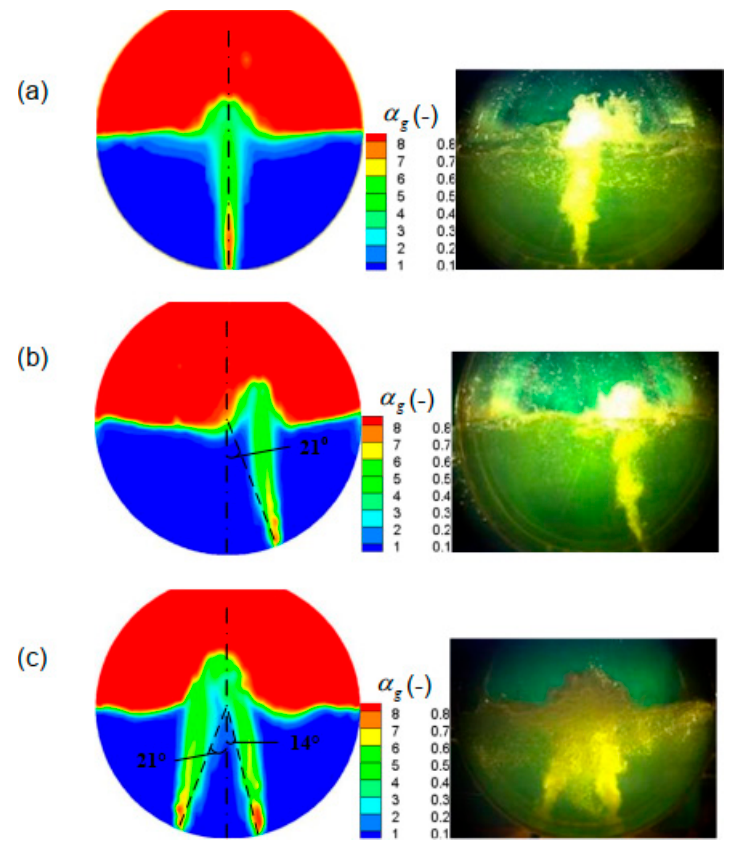
Figure 2. Comparison of the predicted local gas volume fraction with experimental photos in the bath with different nozzle arrangement. The angles of the nozzle arrangement are ( a ) β = 0 ° , ( b ) β = 21 ° , and ( c ) β A = 14 ° , and β B = −21 ° , respectively.